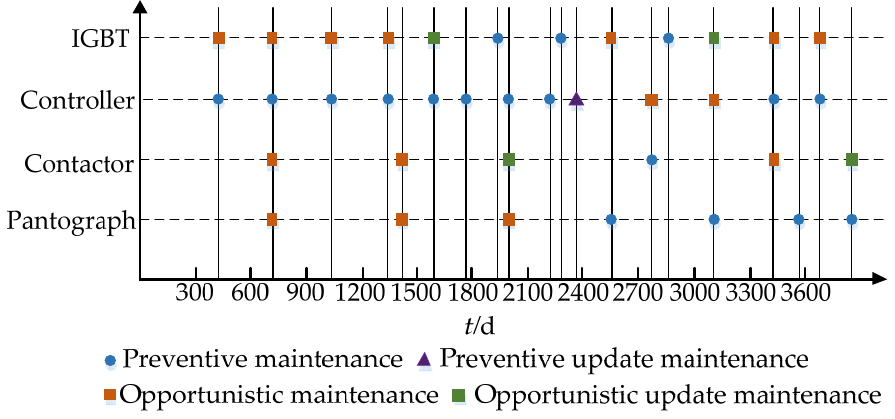
Figure 9. Group preventive maintenance strategy of multi components.